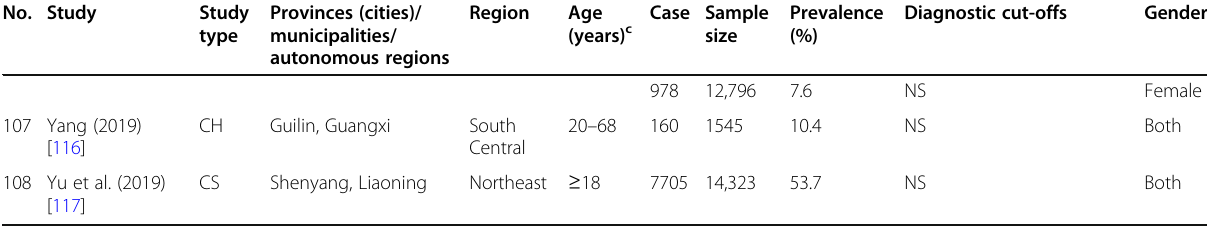
Table 1 Characteristics of the included studies in the systematic review and meta-analysis (Continued) No. Study